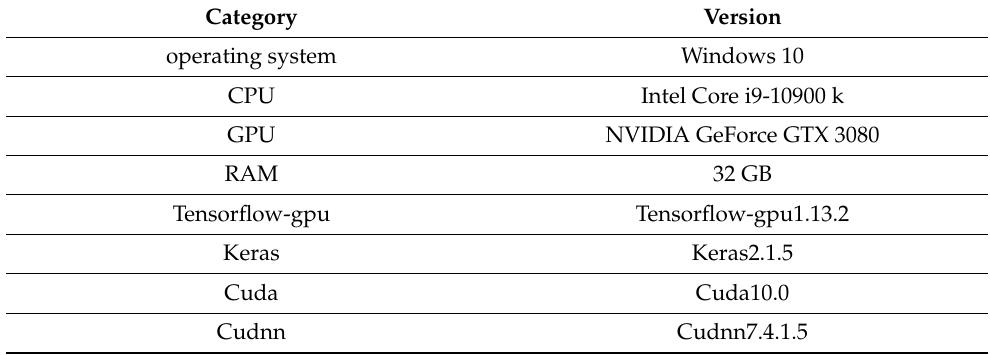
Table 2. Experimental environment.